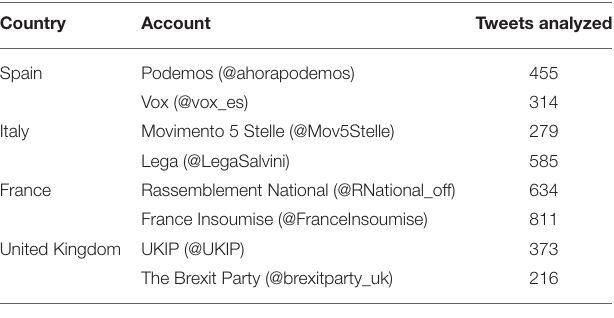
TABLE 1 | Distribution of the